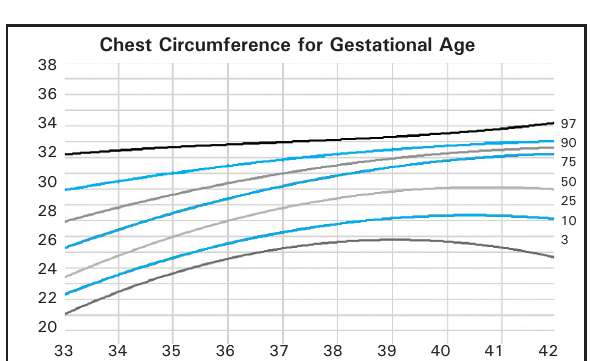
Figure 5. Smoothed curve for chest circumference.